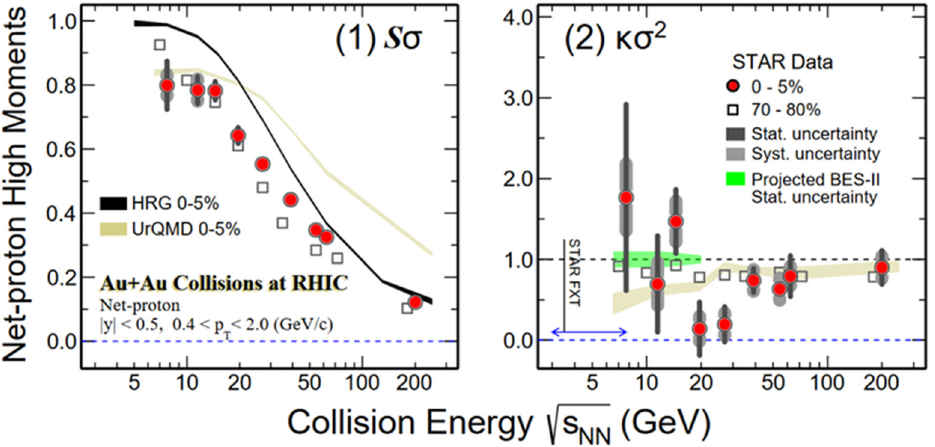
Figure 6. S σ (1) and κσ 2 (2) as a function of collision energy for net-proton distributions measured in Au + Au collisions (see text). Taken from [30].